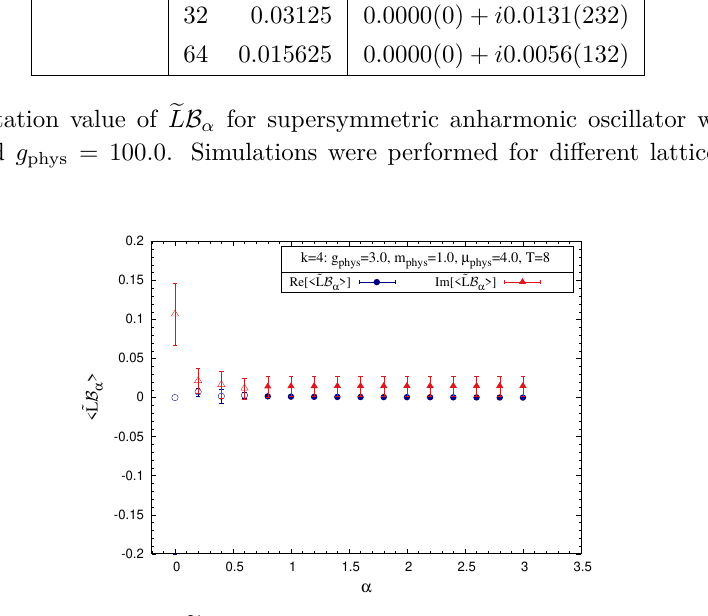
Figure 11 . Expectation values of e L B α for various α values, on a T = 8 lattice, for the model with even-degree ( k = 4 ) polynomial potential, given in eq. (4.7). The parameters used are g phys = 3 , m phys = 1 , and µ phys = 4 . 0